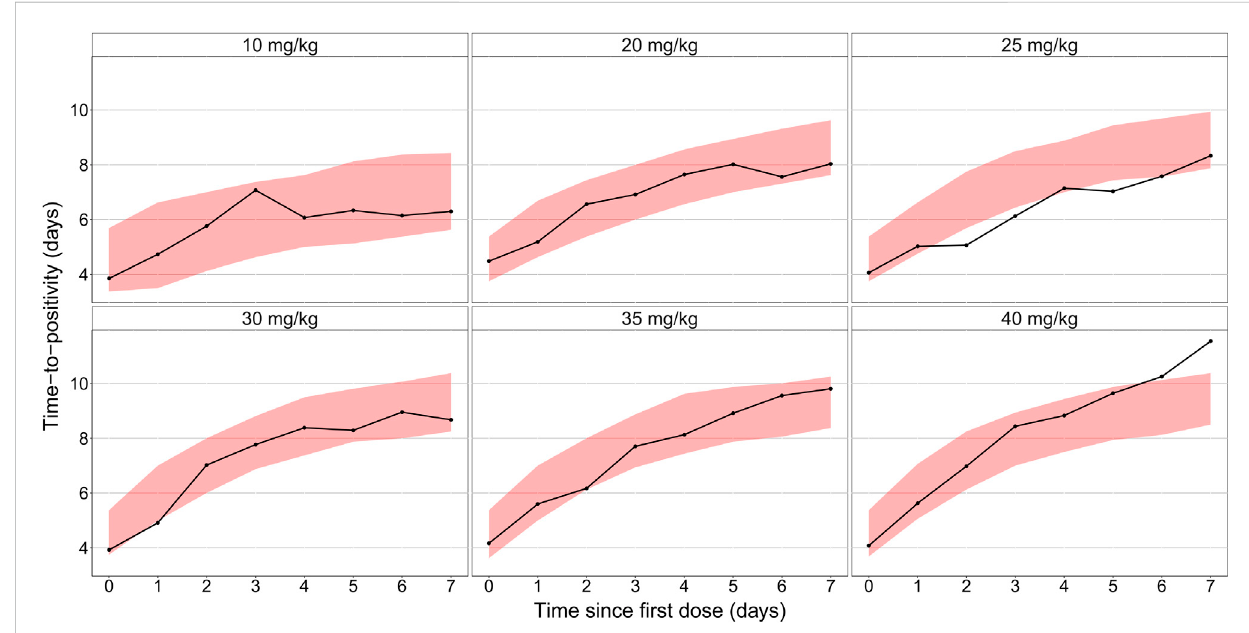
FIGURE 3 Posterior predictive check of the fi nal quantitative biomarker model describing median time-to-positivity (TTP) versus time since fi rst dose and strati fi ed per rifampicin dose group. Solid lines represent the median time to positivity based on the observed data. Shaded areas are the 90% prediction interval based on 1,000 simulations using the